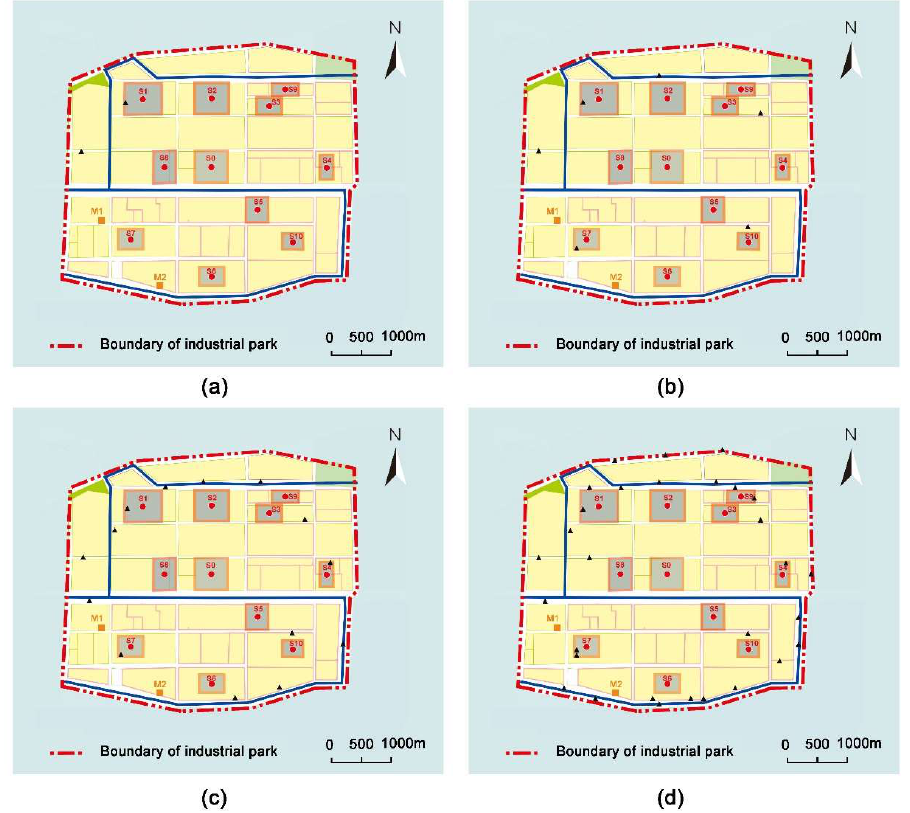
Figure 5. The spatial distributions of the optimal air quality monitoring networks (AQMNs) with di ff erent known numbers of monitors. Orange squares indicate two existing monitors, and black triangles indicate added monitors in the optimal scheme. The numbers of monitors are ( a ) 4, ( b ) 8, ( c ) 16, and ( d ) 32.